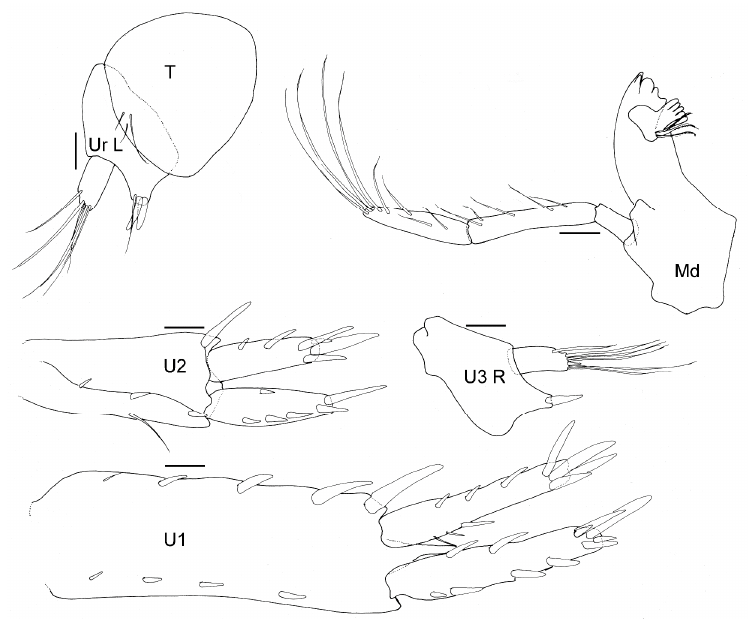
Figure 15. Unciola icelandica sp. nov. paratype female, 6 mm, ZMHK 62086, South Island, Iceland Basin, 1921 m. Scales: 0.1 mm.